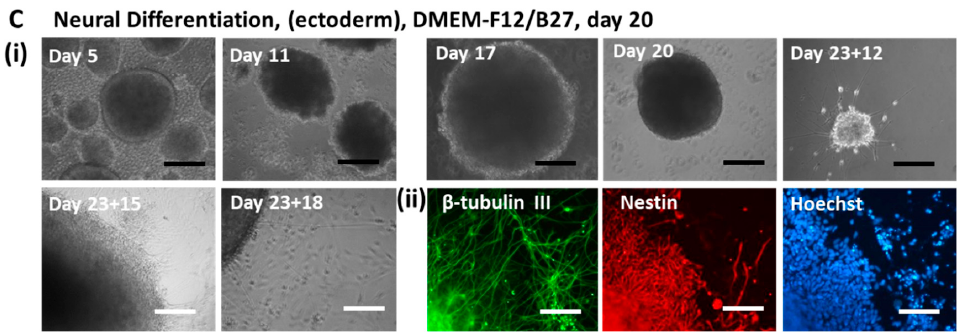
Figure 1. Illustration of different hiPSC cultures for EV/exosome isolation. ( A ) Undifferentiated (i) iPSK3 cells (healthy) and (ii) SY-UBH cells (from an unidentified early-onset Alzheimer’s patient); ( B ) cardiovascular mesoderm differentiation from iPSK3 cells: (i) culture morphology at day 20; (ii) expression of α -actinin and Nkx2.5 for cardiomyocyte identity. The two pictures show the variations in morphology of different cultures during the days that the conditioned media were collected. ( C ) Generation and characterization of ectodermal neural progenitor cells (NPCs) from iPSK3 cells: (i) cortical spheroid morphology over time. The cortical spheroids were replated at day 23 on Geltrex-coated surface. The axons grew out of the spheroids. (ii) Expression of Nestin and β -tubulin III for neuron identity (day 24). Scale bar: white—100 µm, yellow—25 µm, black—200 µm.